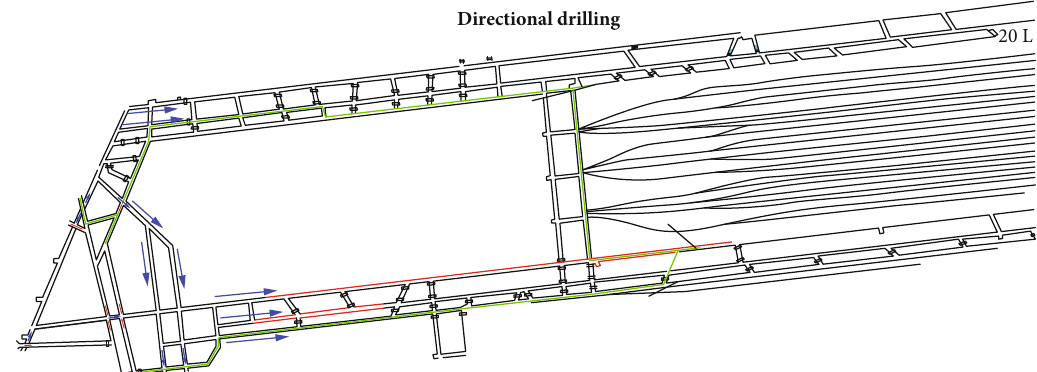
Figure 8: Gas drainage from directional boreholes in the main drainage channel.